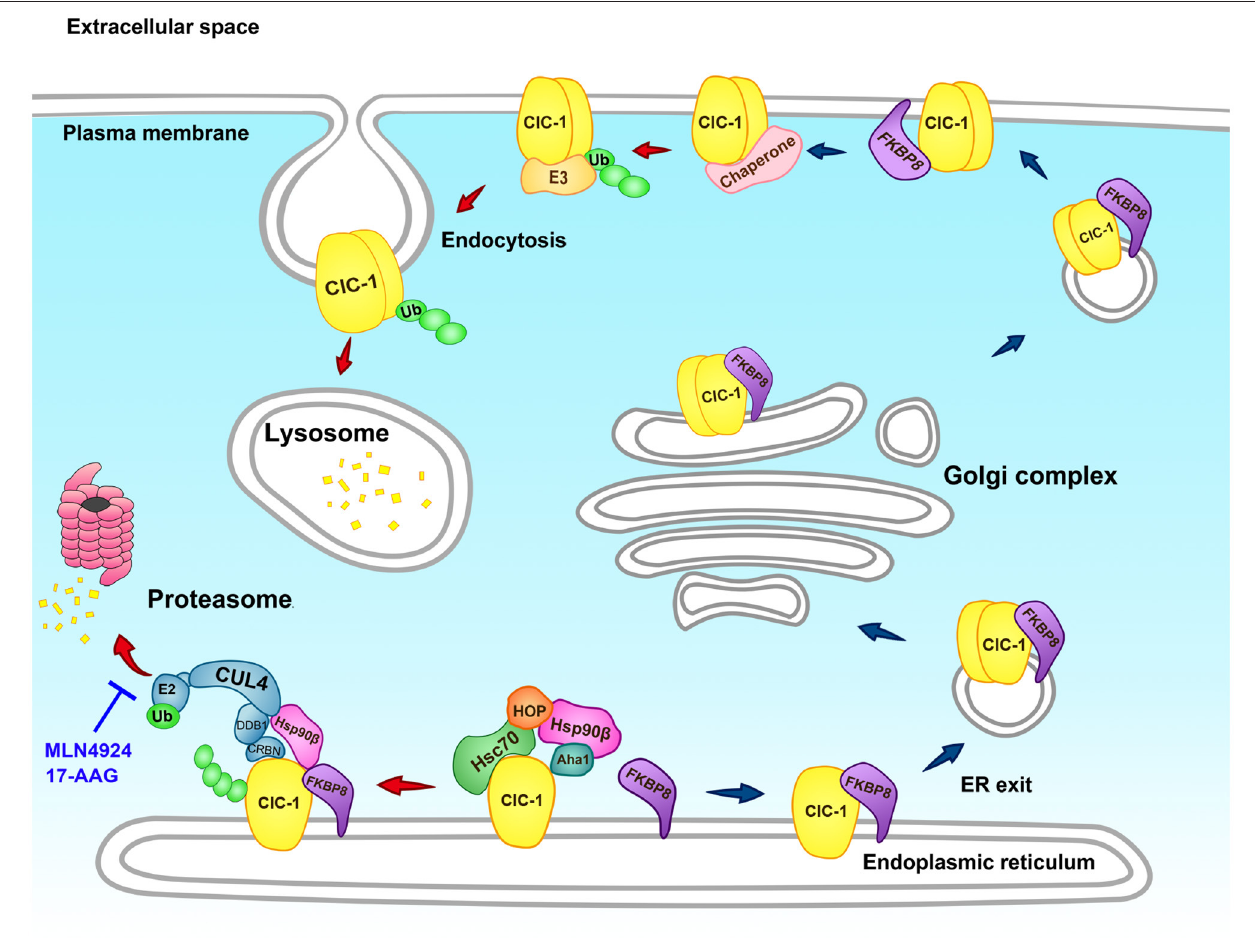
FIGURE 4 | Schematic model of the proteostasis network of the human ClC-1 channel. The endoplasmic reticulum (ER) quality control system of the CLC-1 protein comprises of the constitutively expressed molecular chaperones Hsc70 and Hsp90 β , as well as the cochaperones HOP, Aha1, and FKBP8. Hsc70 and HOP assist the early stage of ClC-1 folding, whereas Aha1, Hsp90 β , and FKBP8 promote the late stage of ClC-1 folding. ER-associated degradation of ClC-1 is mediated by the CUL4-DDB1-CRBN E3 ubiquitin ligase complex that catalyzes the transfer of ubiquitin (Ub) from the E2 ubiquitin-conjugating enzyme (E2) for covalent linkage to ClC-1. Ubiquitinated ClC-1 is targeted for eventual degradation by the proteasome. Hsp90 β and FKBP8 may additionally regulate ER-associated degradation of ClC-1 by modulating the protein stability of CRBN, the substrate receptor of the CUL4-DDB1-CRBN ligase complex. Proteasomal degradation of ClC-1 can be effectively attenuated by the cullin E3 ligase blocker MLN4924 and the Hsp90 inhibitor 17-AAG. Moreover, FKBP8 is essential for ER exit and membrane trafficking of ClC-1. At the plasma membrane, FKBP8 further promotes surface ClC-1 protein stability. Other chaperones/cochaperones may also contribute to the peripheral quality control system of ClC-1. Misfolded ClC-1 is subject to ubiquitination by the as yet unknown E3 ubiquitin ligase (E3), followed by endocytosis and lysosomal